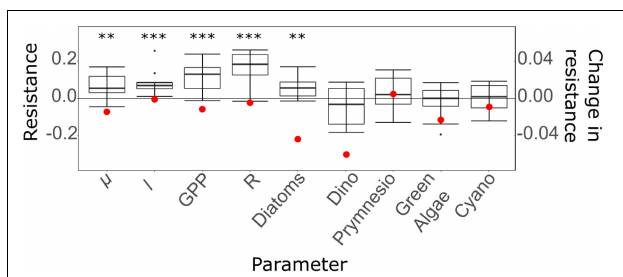
FIGURE 6 | Boxplot of resistance over time and change in resistance over time (red dots) for planktonic processes ( µ , l , GPP, R) and phytoplankton functional types (Dino: dinoflagellates, Prymnesio: prymnesiophytes, Cyano: cyanobacteria). The results of an unpaired t -test testing the difference between resistance and benchmark value (0) for each parameter are presented over the boxplots when a significant p -value was found ( ∗∗ , p < 0.01; ∗∗∗ , p <